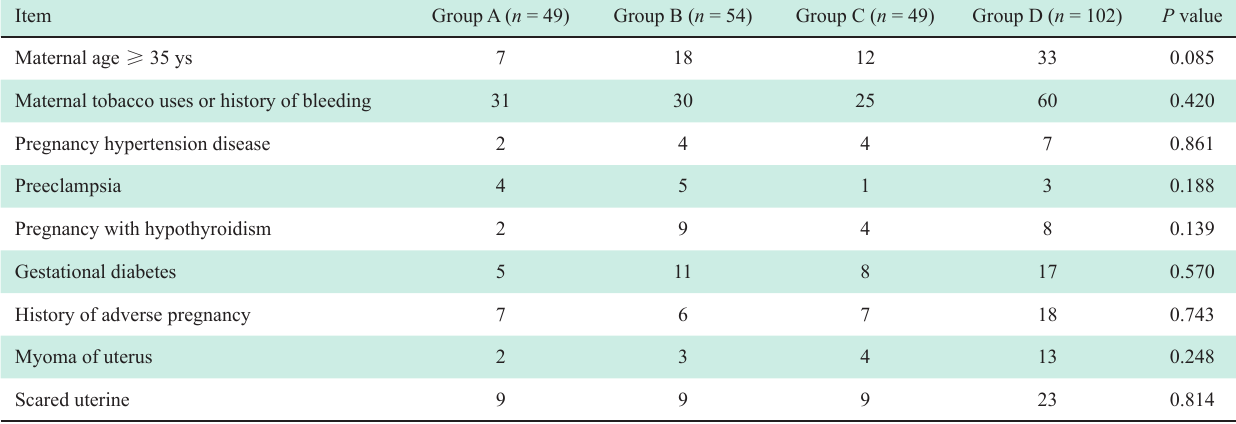
Table 1 Demographic characteristics of study